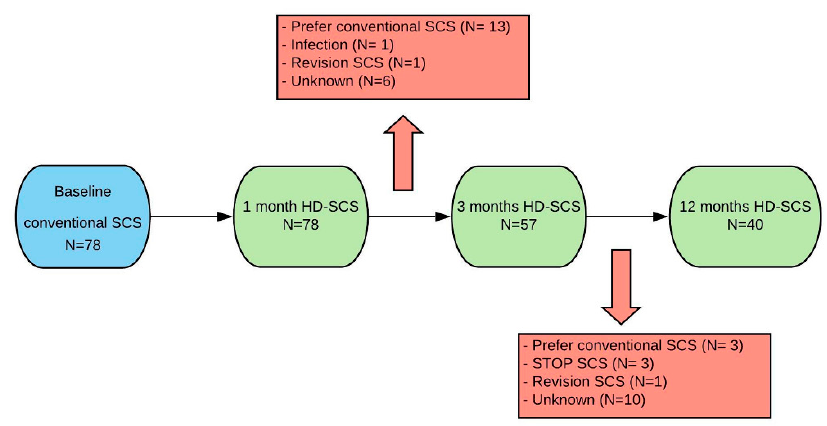
Figure 1. Flow chart of the study. Patients who received the status “unknown” are patients who missed their scheduled outpatient study visit. Abbreviations: HD-SCS: high dose Spinal Cord Stimulation, N: number of patients.